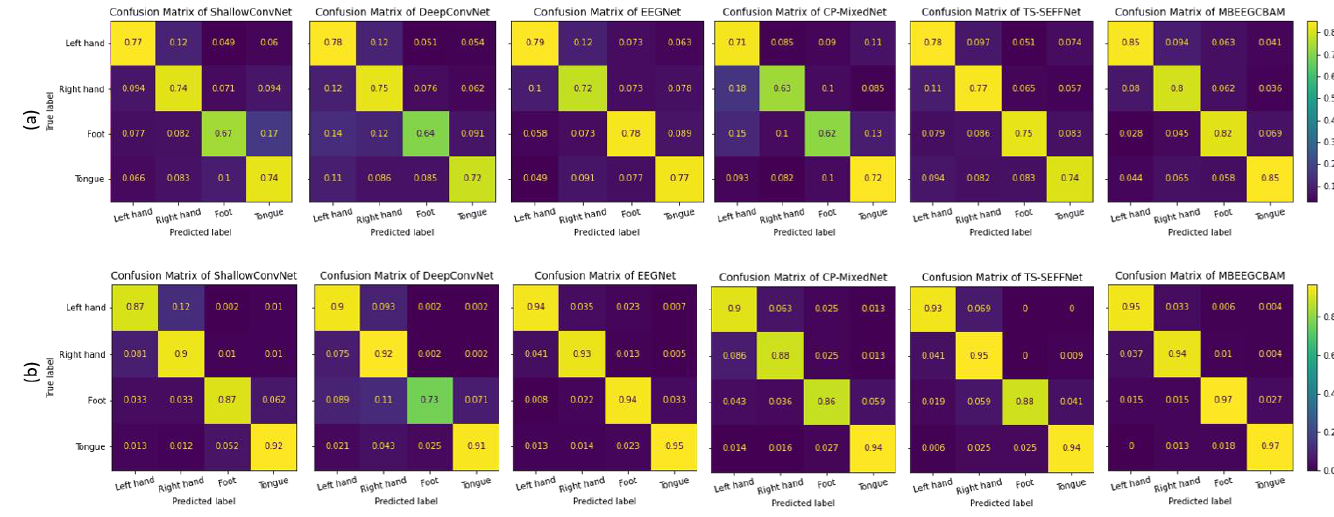
Figure 10. The average confusion matrices for all subjects on both datasets ( a ) the BCI-IV2a, ( b ) the HGD.